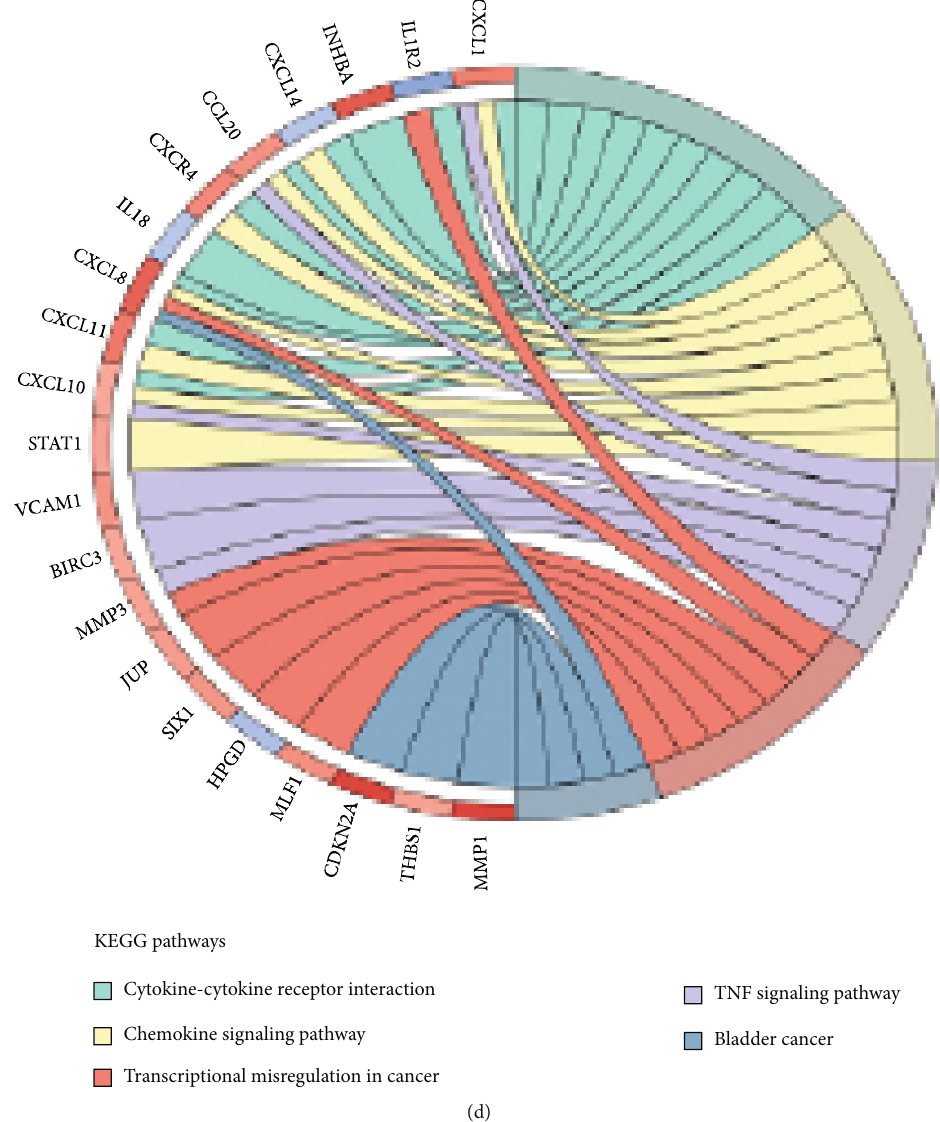
Figure 2: Screening for DEGs in samples from patients with CC. (a) PCA plot showing signi fi cant di ff erential clustering between CC (red spheres) and normal cervical (yellow spheres) tissue samples. (b) Volcano plots depicting changes in mRNA expression between the normal cervical tissue ( n = 32 ) and CC ( n = 98 ) groups. There were 106 and 101 mRNAs with ∣ log 2 ð foldchange Þ ∣ >1 : 5 that were signi fi cantly ( p < 0 : 05 ) upregulated (red) and downregulated (blue) in the CC group compared to the normal cervical tissue group. (c, d) GO and KEGG enrichment analyses of DEGs in CC samples. CC: cervical cancer; DEG: di ff erentially expressed gene; PCA: principal component analysis; FC: fold change; GO: Gene Ontology; KEGG: Kyoto Encyclopedia of Genes and